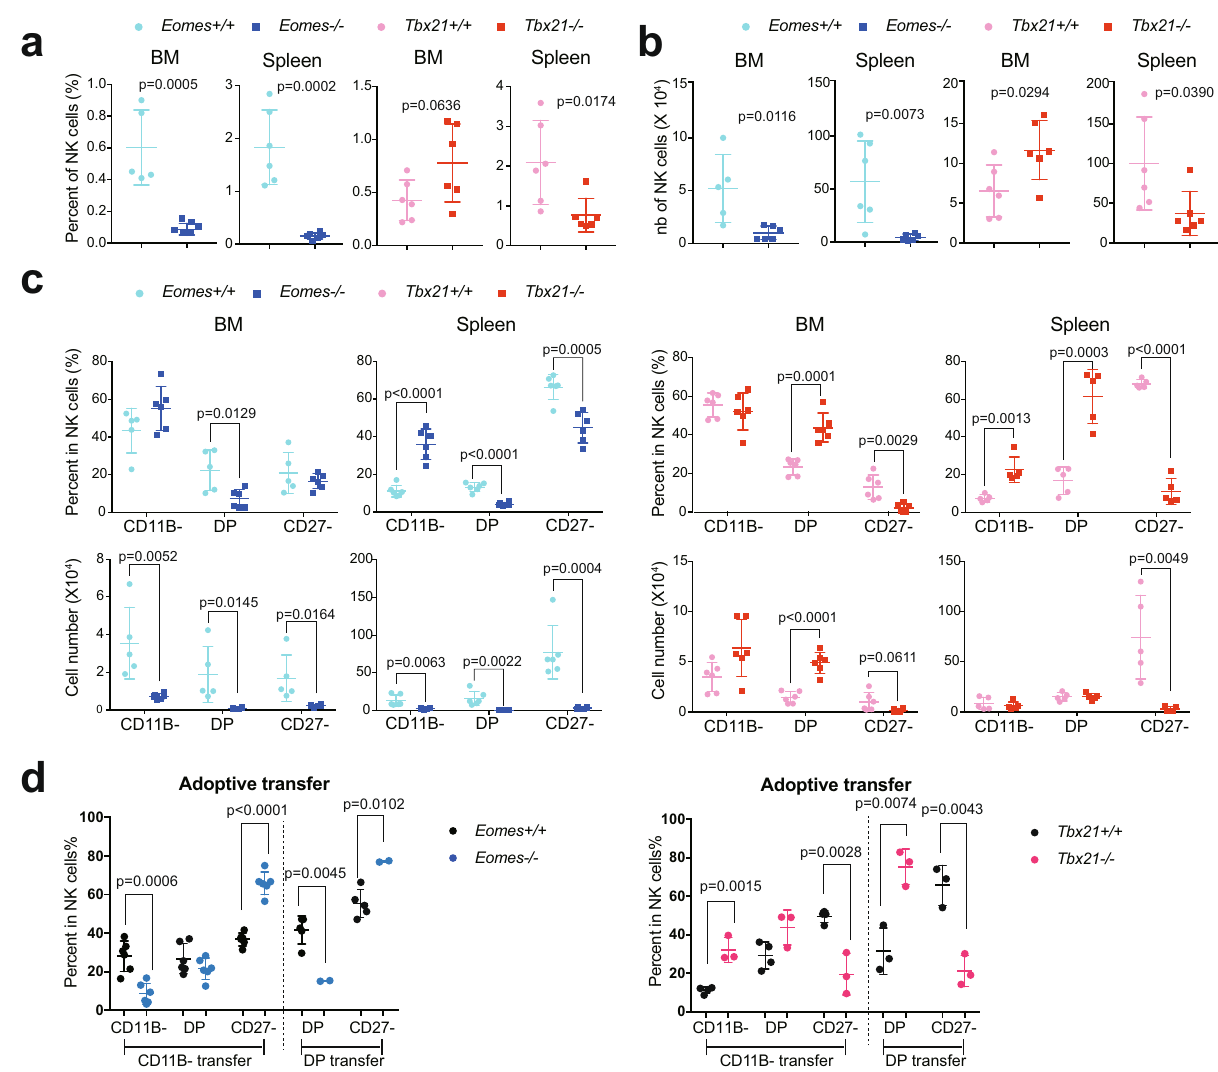
Fig. 2 EOMES and T-BET promote NK cell survival and differentiation at different cellular transitions. a Flow cytometry analysis of NK cell percentage in BM or spleen lymphocytes of the indicated mice. Each dot corresponds to a single mouse ( n = 5 – 6 mice in each group, pooled from 2 experiments). b Number of NK cells calculated from data in ( a ) combined with numeration of corresponding organs ( n = 5 – 6, pooled from 2 experiments). c Proportion and numbers of NK cell subsets in BM or spleen lymphocytes of the indicated mice. Each dot corresponds to a single mouse ( n = 5 – 6 mice in each group, pooled from 2 experiments). d NK cells of the indicated subsets (CD11B- or DP) and genotypes were FACS-sorted and then adoptively transferred into congenic unirradiated Ly5a X B6 mice (CD45.1/2). Two weeks later, spleen NK cells were puri fi ed from these mice and the CD11B/CD27 phenotype of transferred NK cells (identi fi ed by their CD45.2 expression) was analyzed by fl ow cytometry ( n = 2 – 6, pooled from 2 experiments). In all graphs in Fig.